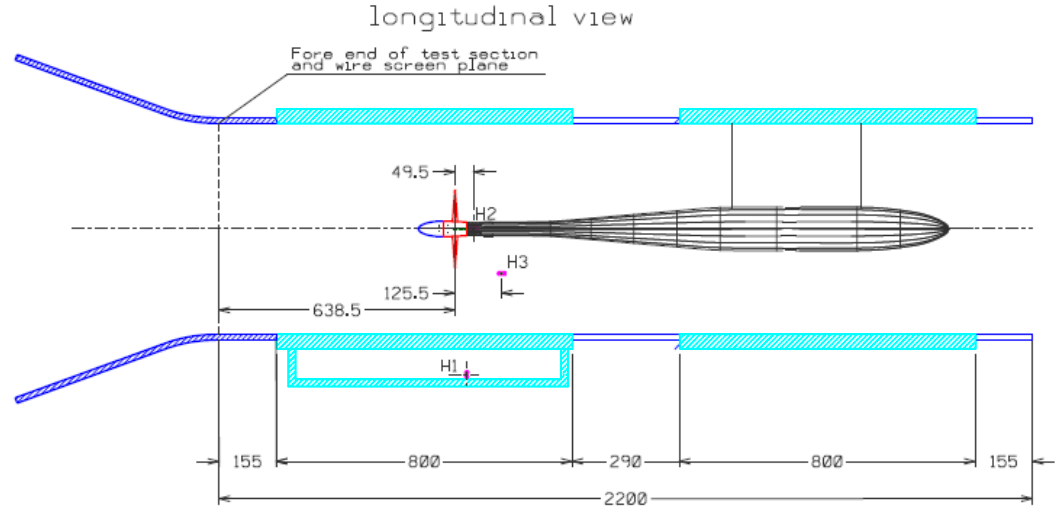
Figure 11. Cavitation tunnel setup, longitudinal view. Table 2. Full-scale operational conditions during sea trials.